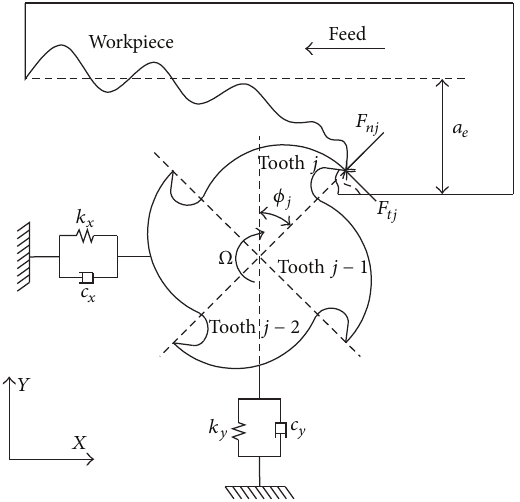
Figure 1: Dynamic model of the milling